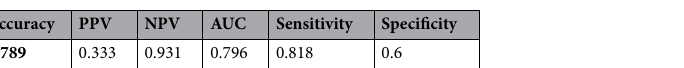
Table 4. Results of ROC curve analysis on POD 5 (cutoff value, 160 mg/L). AUC, area under the curve; NPV, negative predictive value; POD, postoperative day; PPV, positive predictive value; ROC, receiver operating characteristic.